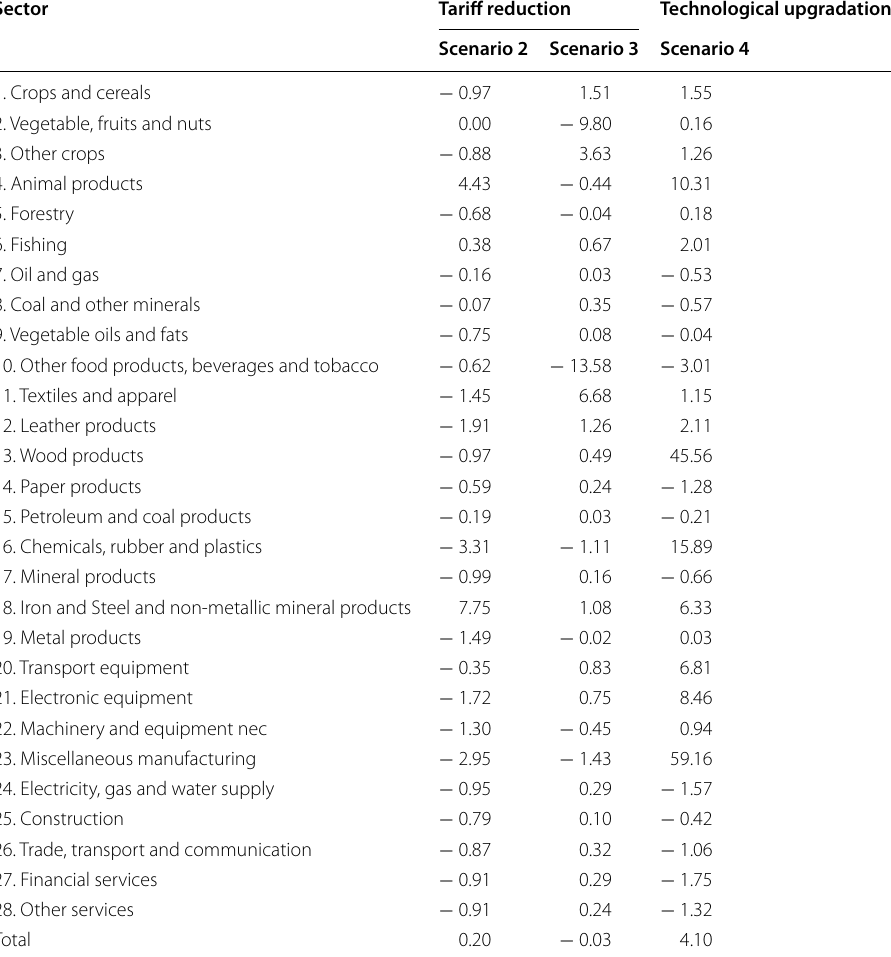
Table 5 Sectoral export growth due to tariff simulation and technological upgradation at 2030 compared to BAU 2030 (without USA as TPP